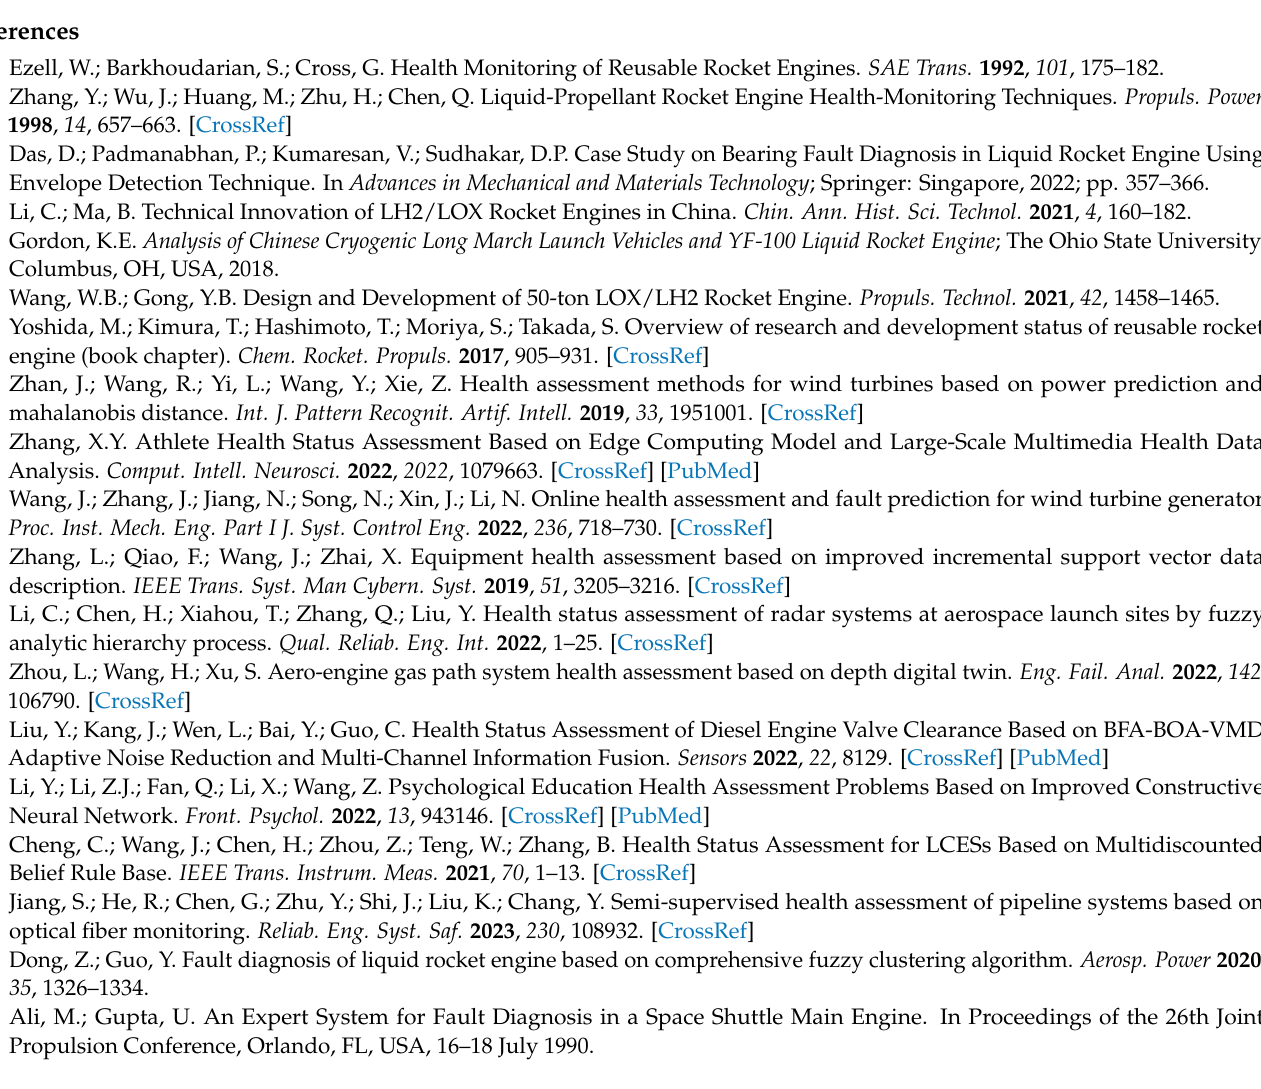
It follows from Formula (13) that the expected utility is 0.9925. Since it is less than the set threshold of 0.1, we set it equal to 1 and plot the